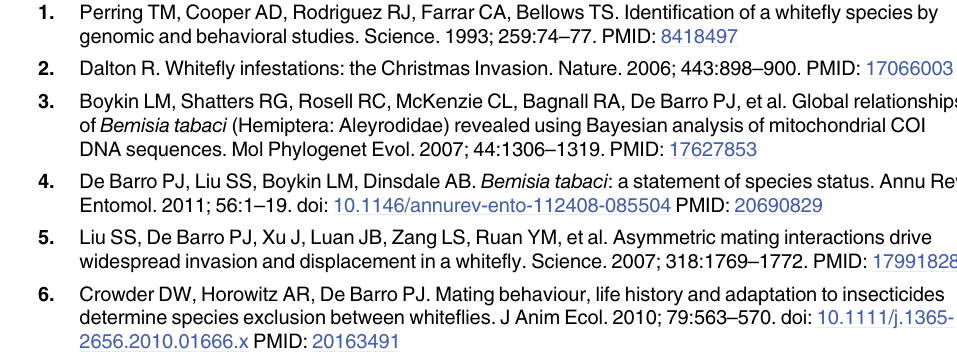
S11 Table. Expression of transporters. List of amino acid transporters and their expression value in B . tabaci